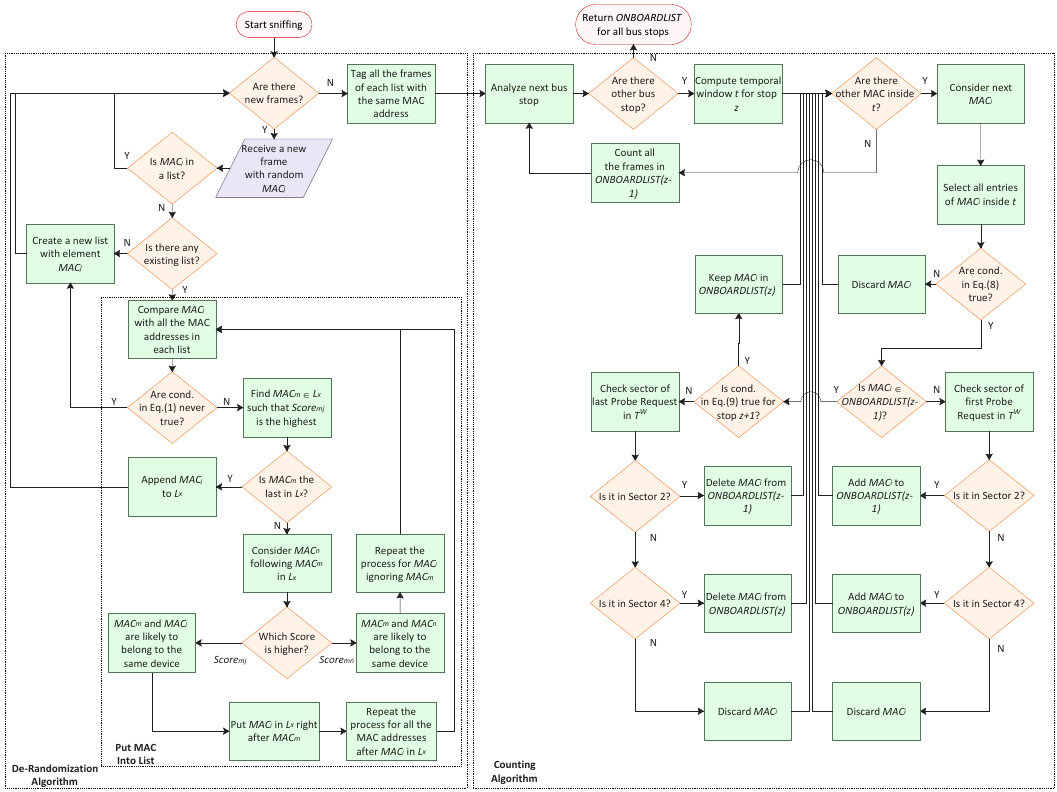
Figure 4. Flow chart of the